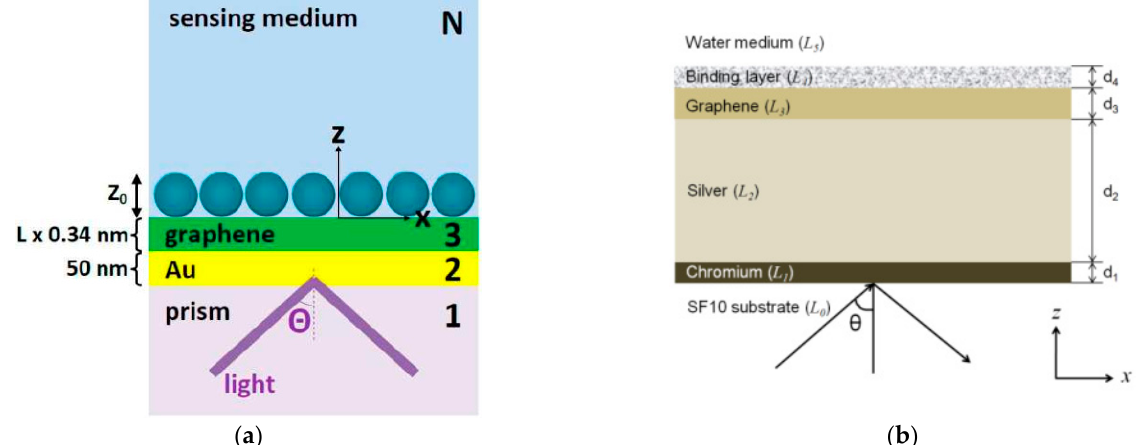
Figure 3. The SPR structure investigated by: ( a ) Wu et al. (left) and ( b ) Choi et al. (right) (adapted with permission from References [31,32] © The Optical Society).